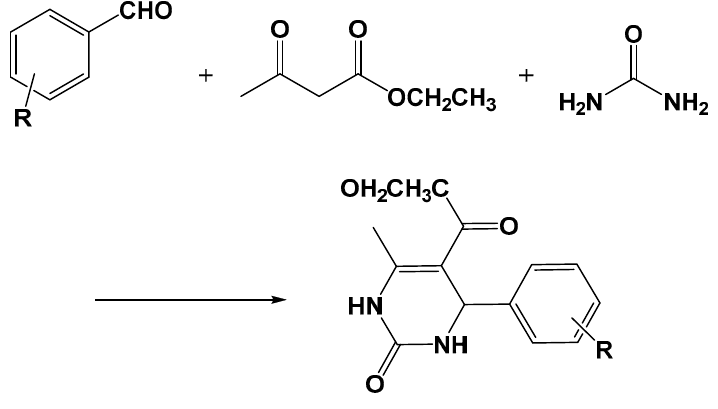
Table 3. Synthesis of various dihydropyrimidones on PW 12 /H β and SiW 12 /H β